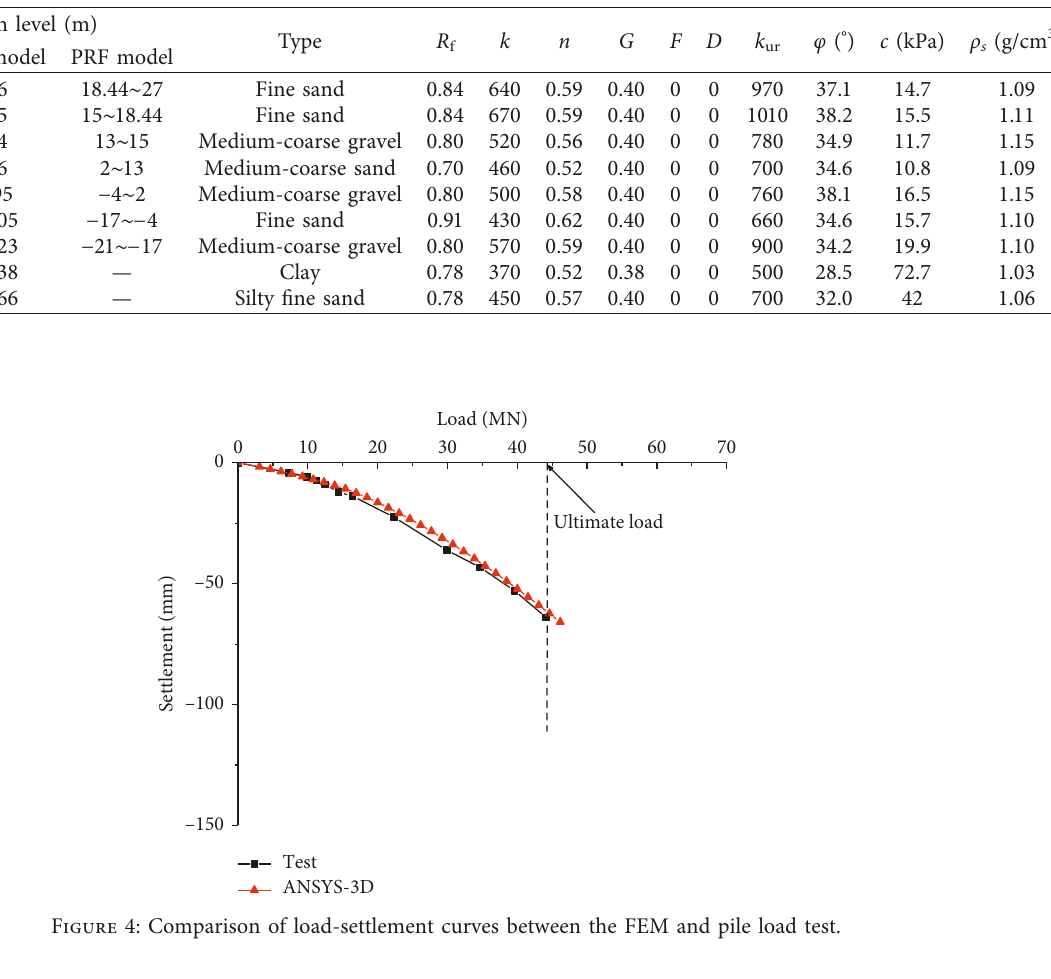
Table 2: Parameters of the DC model used in this paper.